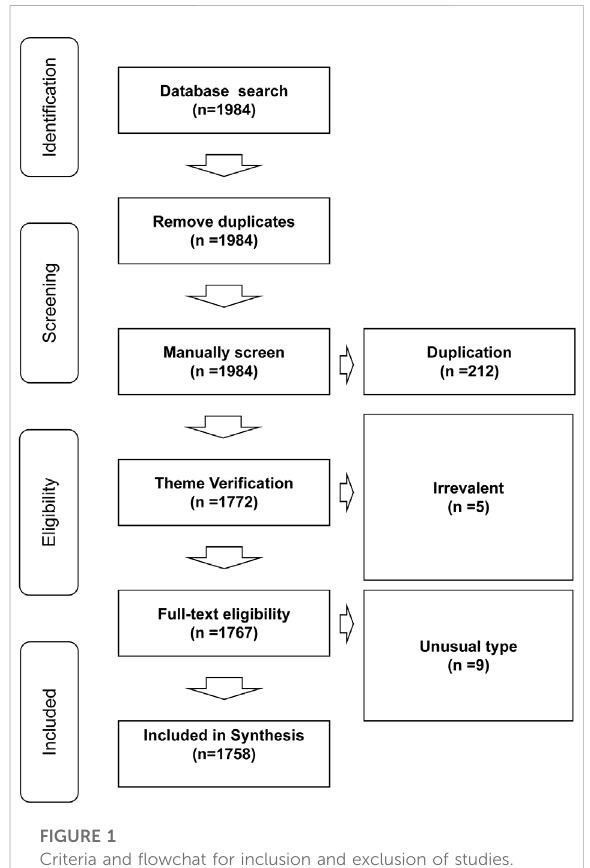
FIGURE 1 Criteria and fl owchat for inclusion and exclusion of